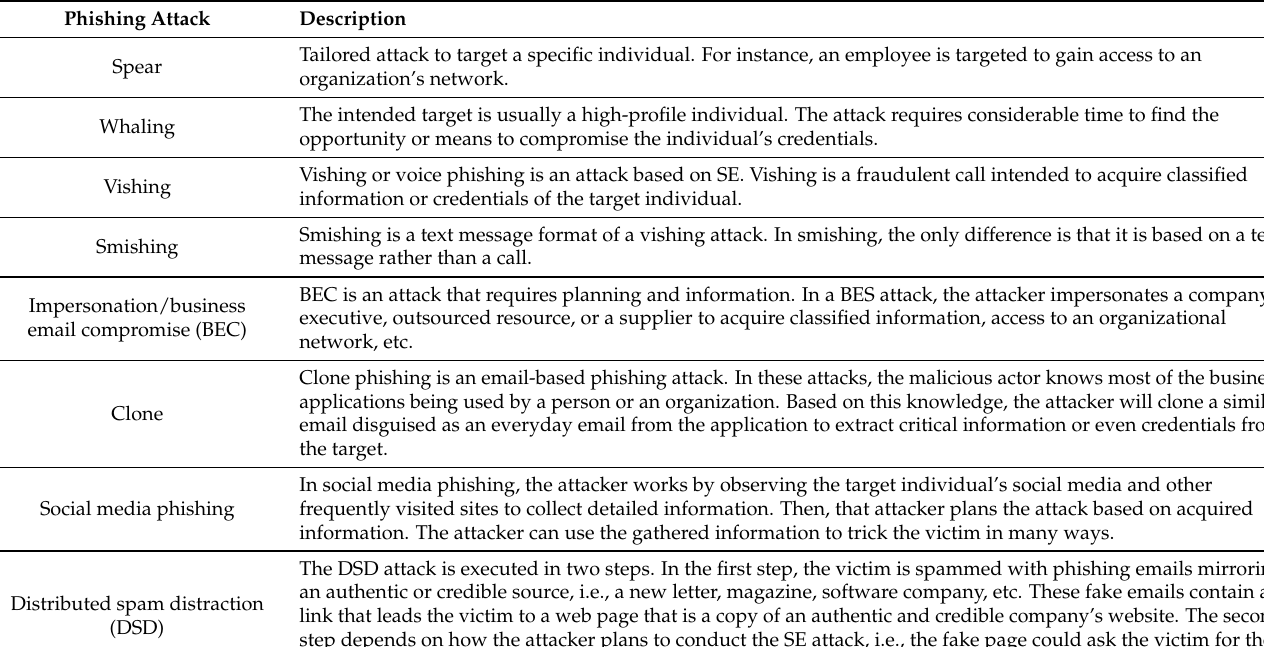
Table 2. Common types of phishing attacks.